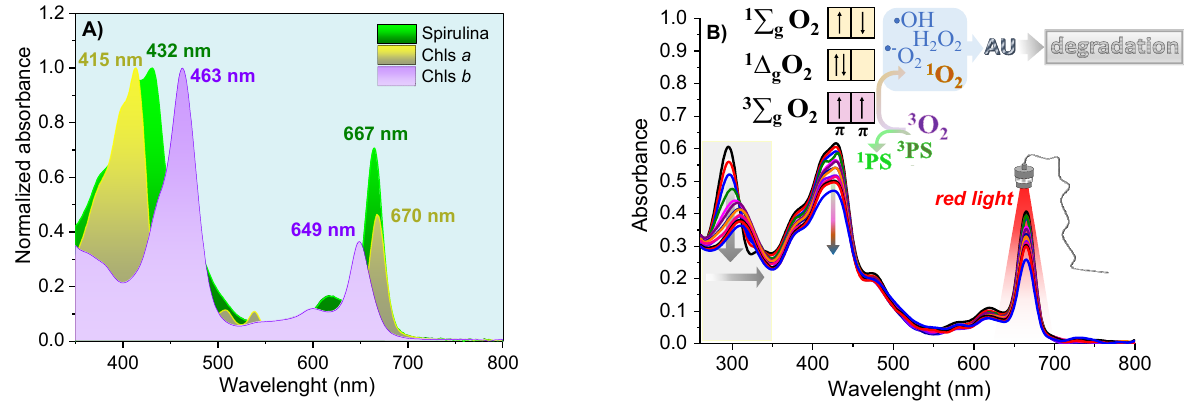
Figure 5. The normalized electronic absorption spectra for Spirulina sp. and purified Chls ( A ); and solution of Spirulina sp. 4 mg/mL and 29 µ mol/L of UA in ethanol ( B ), under 70 min illumination with red light.